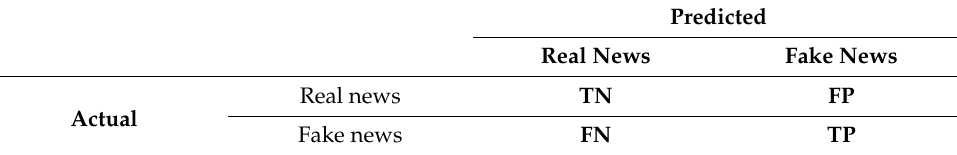
Predicted Real News Fake News